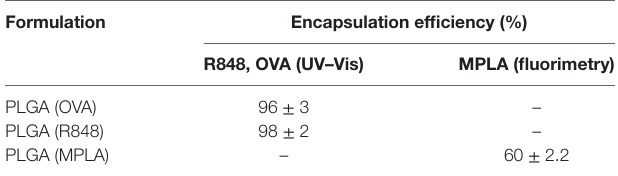
TaBle 3 | The encapsulation efficiency of different formulations.